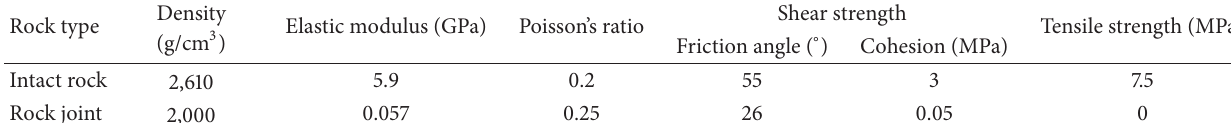
Table 3: Physicomechanical parameters of intact rock mass and precast fissure.